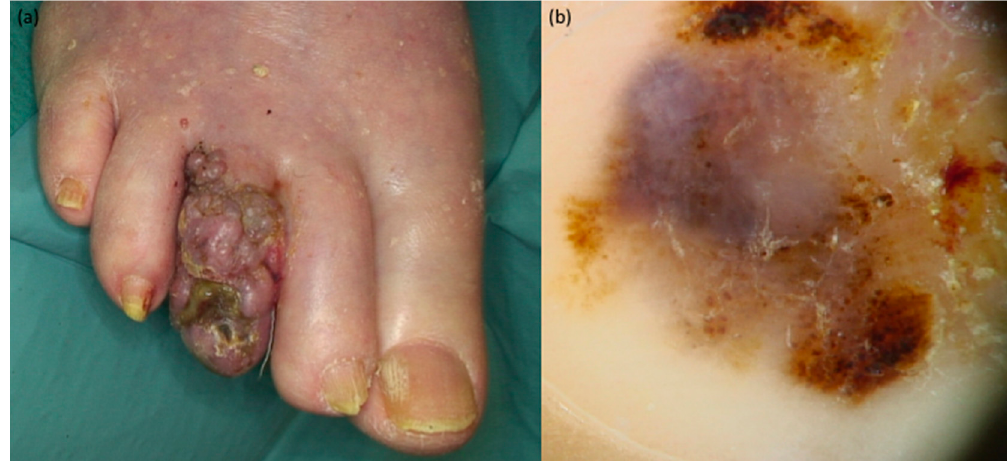
Figure 2. Nail melanoma of the 3rd digit of the foot: ( a ) clinical presentation showing neoplastic cutaneous spread to the periungual tissues and Hutchinson’s sign: an exophytic and verrucous growth is observed. Dermoscopy ( b ) reveals bluish, black and milky-red structureless areas and irregular brown dots.